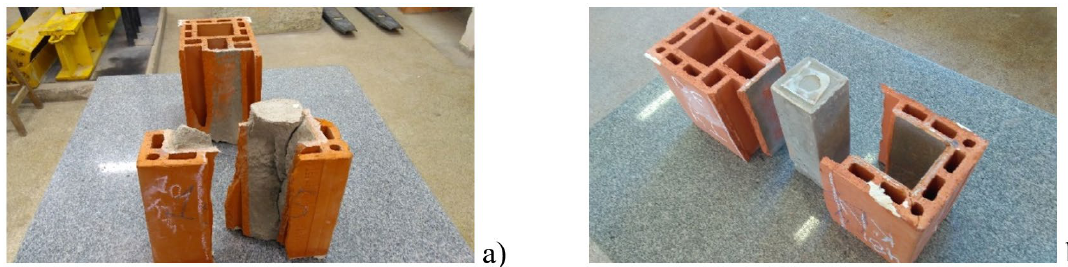
Figure 11. BV0 specimens after push-out test.